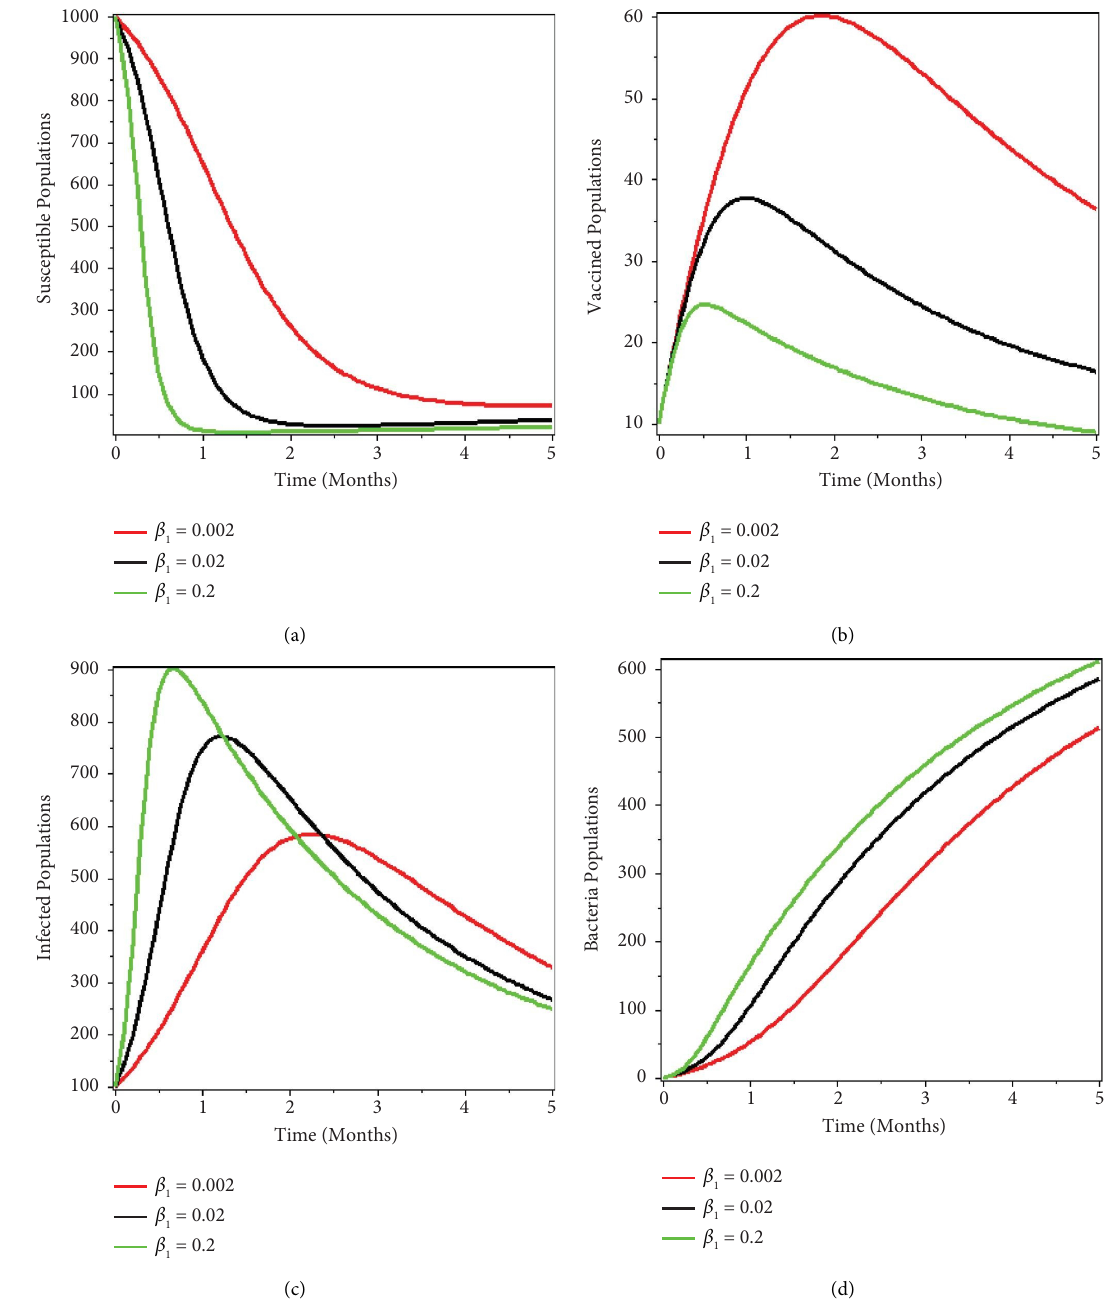
Figure 3: Efect of varying β